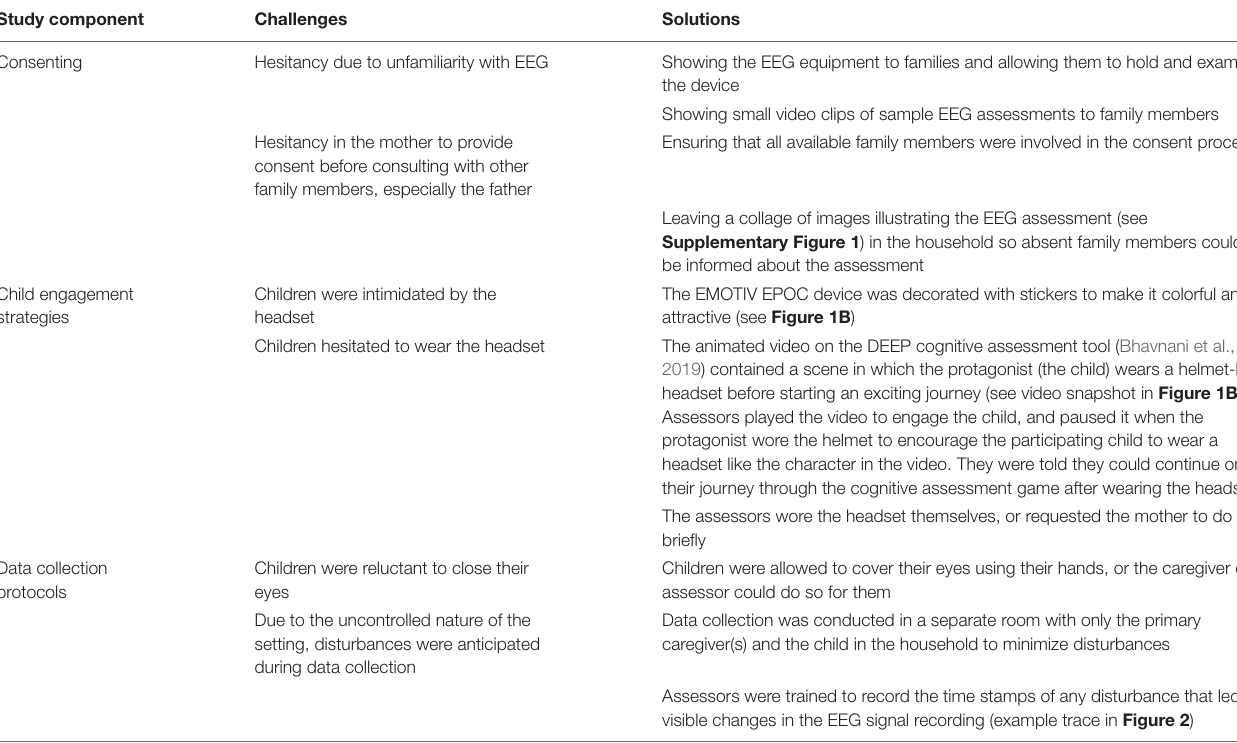
TABLE 1 | Standard operating procedures informed by the formative phase of this